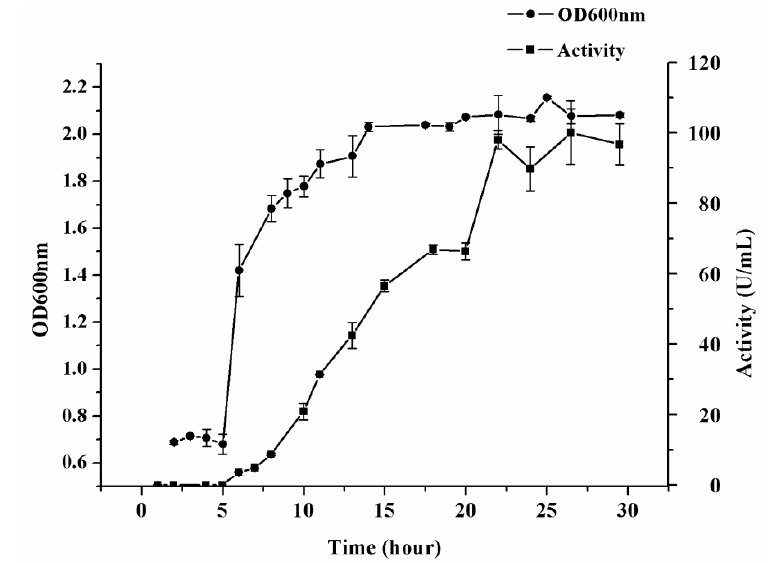
Figure 3. The growth and pseudoalterin production of strain CF6-2 cultured under the predicted optimal conditions. The culture medium consisted of 1.2% artery, 0.3% yeast extract, 0.5 mM CaCl and 0.5 mM Na HPO , the initial pH was adjusted to 8.5, the culture 2 2 4 temperature was 20 °C, and the culture volume was 50 mL/500 mL. The graph shows data from triplicate treatments (mean ±